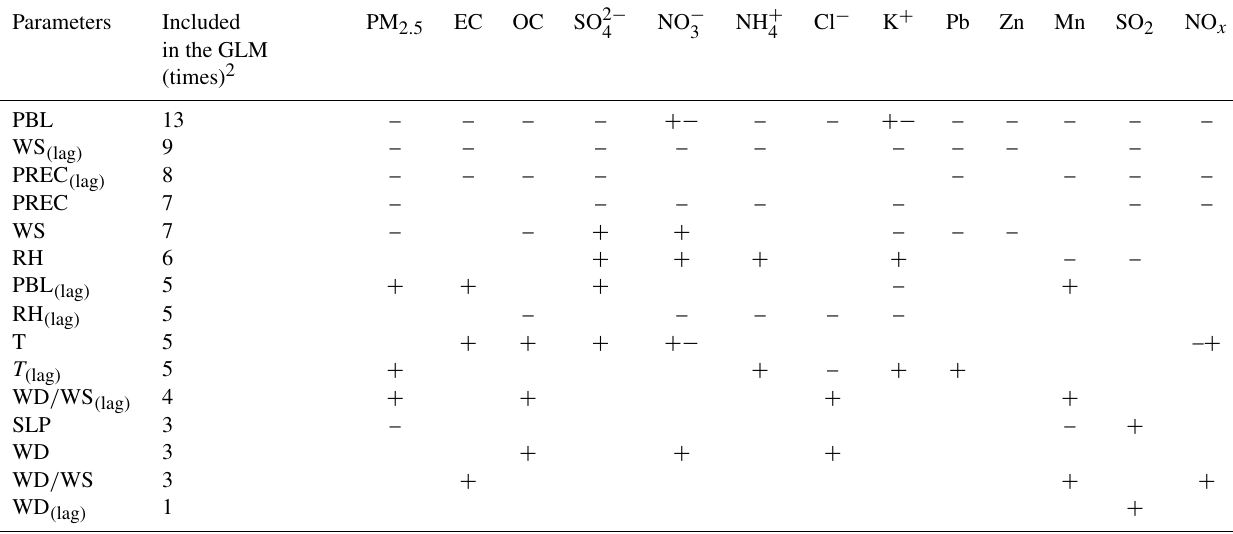
Table 8. The influence of the meteorological parameters included in the GLMs on pollutant concentrations 1 .